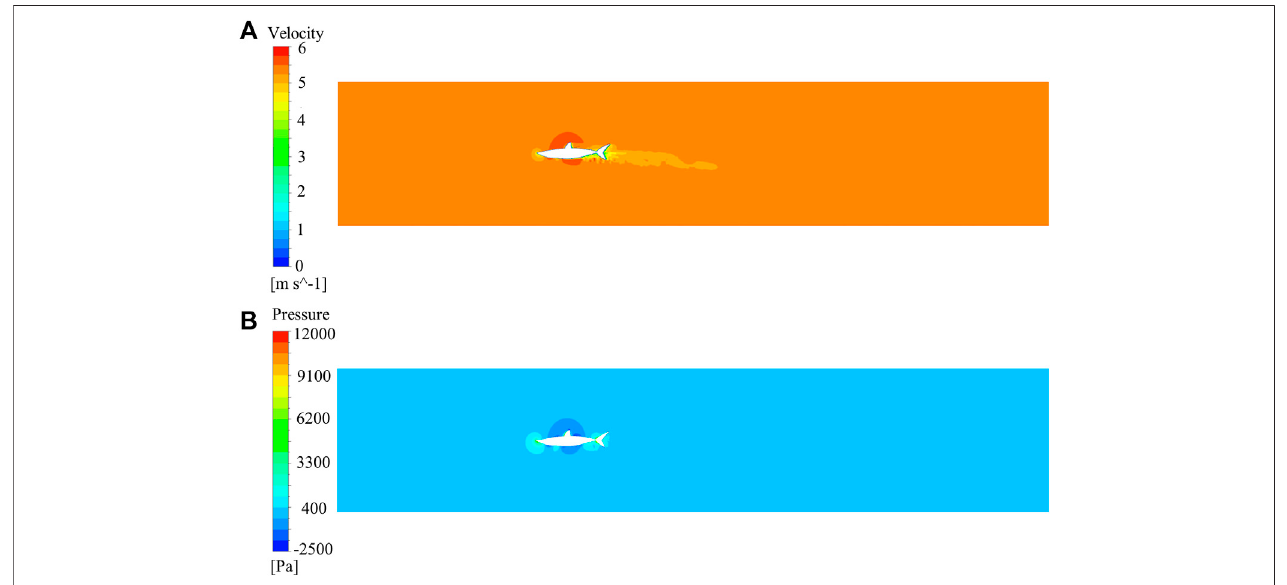
FIGURE 5 | Contours for the whole computational domain of the shark model. (A) Velocity contour, (B) Pressure contour.